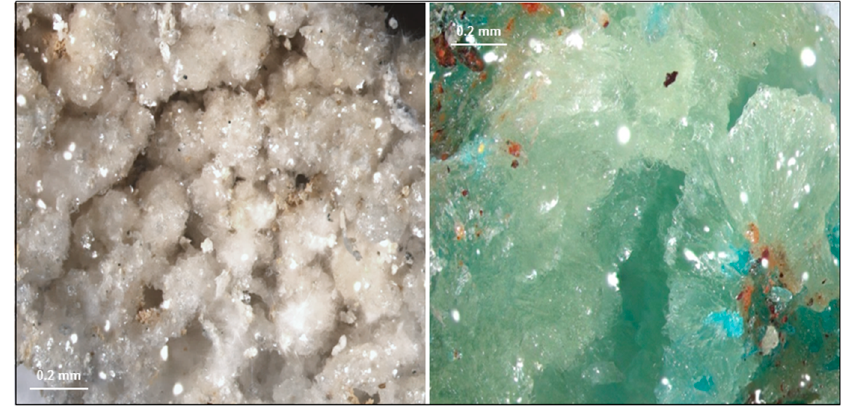
Figure 5. Alunogen (stereomicroscope images) in the Algares adit.